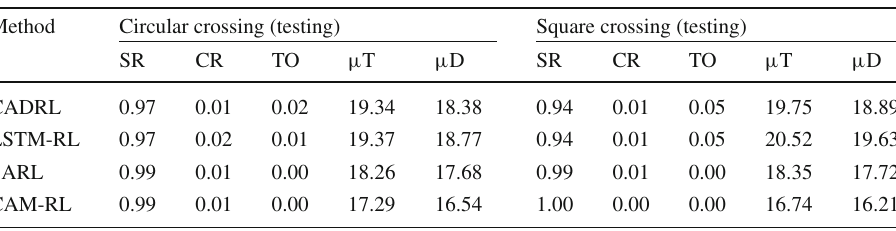
Table 5 The statistical analysis of experimental results using Wilcoxon